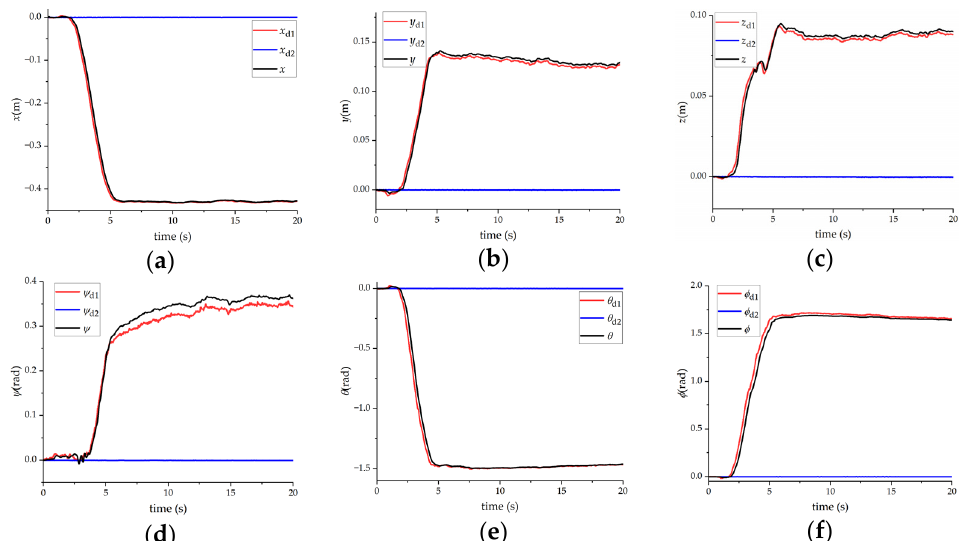
Figure 16. Pose of the VR handle and the virtual object in the first experiment: ( a ) the x component; ( b ) the y component; ( c ) the z component; ( d ) the φ component; ( e ) the θ component; and ( f ) the ψ component.